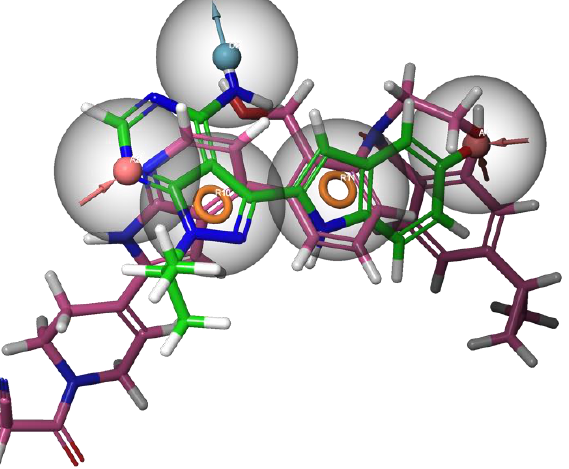
Figure 2. A sample pharmacophore of two known P2X7 antagonists coloured in fuchsia and green. The ligands have been clustered such that similar molecular features are aligned with each other and the pharmacophore. This sample pharmacophore constitutes five key features. Two aromatic groups are represented by the orange rings, two hydrogen bond acceptors by pink spheres and hydrogen bond donors by light blue spheres. The grey spheres surrounding these features are known as exclusion volumes, which mimic what the protein binding pocket is expected to look like. Thus, query ligands must not enter these regions to prevent steric clashes. The collection of these features is what is expected to contribute most to drug receptor interactions.